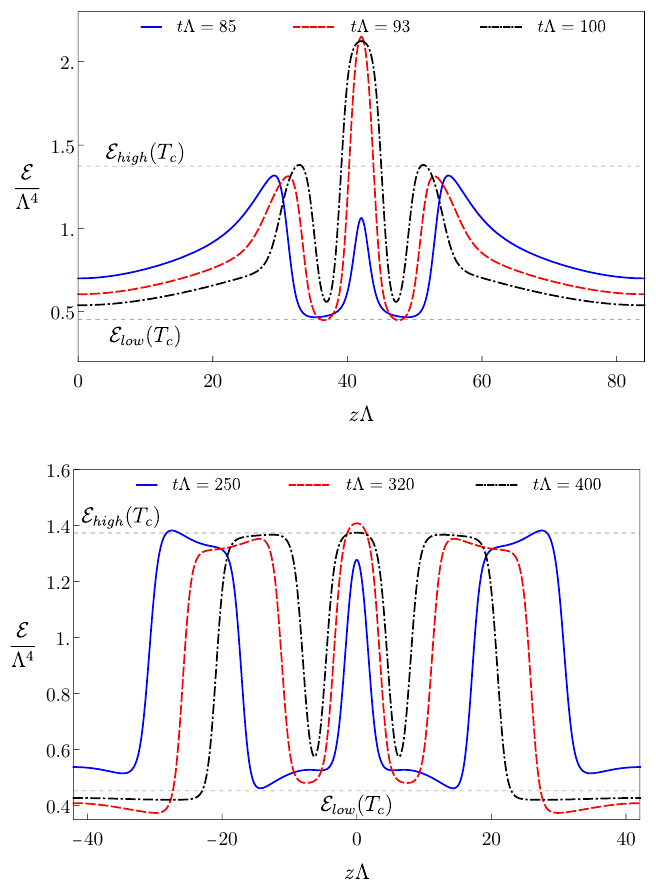
Figure 22 . Snapshots of the energy density for the evolution in figure 19(bottom) with v max = 0 . 73 . The top (bottom) plot corresponds to a time shortly after the second (fourth) collision. The blue curve corresponds to a time soon after the fragmentation of the excited state.